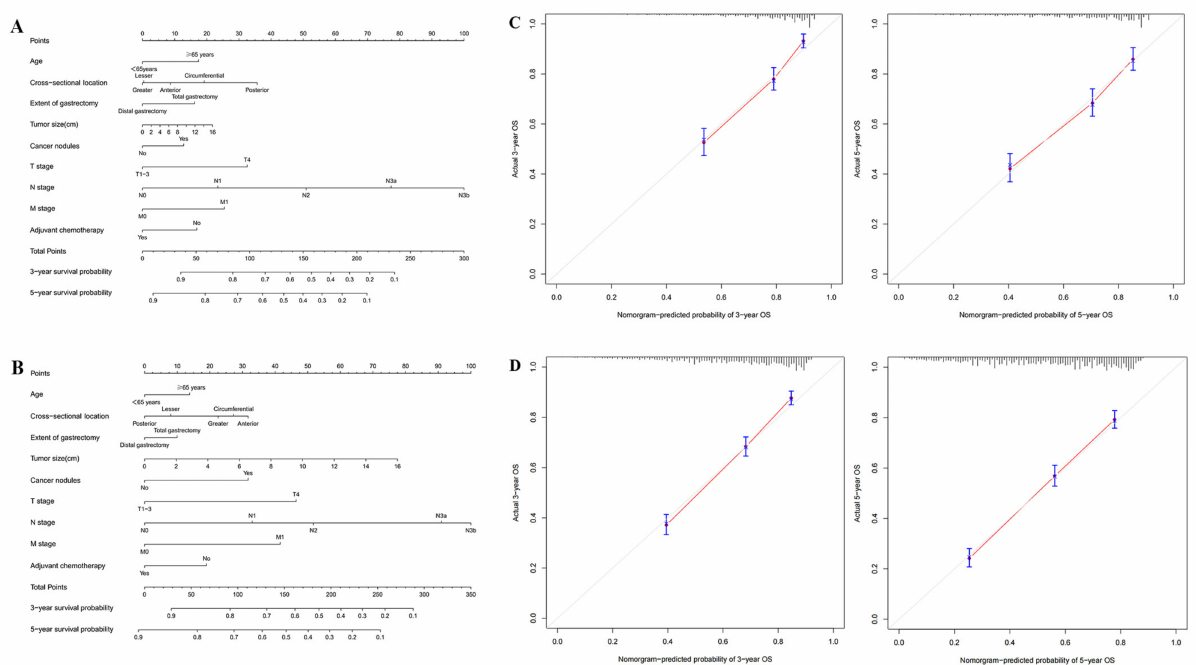
Figure 4. ( A ) Nomogram of No. 12a LND compliant patients; ( B ) Nomogram of No. 12a LND noncompliant patients; ( C ) Calibration curves for nomogram of No. 12a LND compliant patients; ( D ) Calibration curves for nomogram of No. 12a LND noncompliant